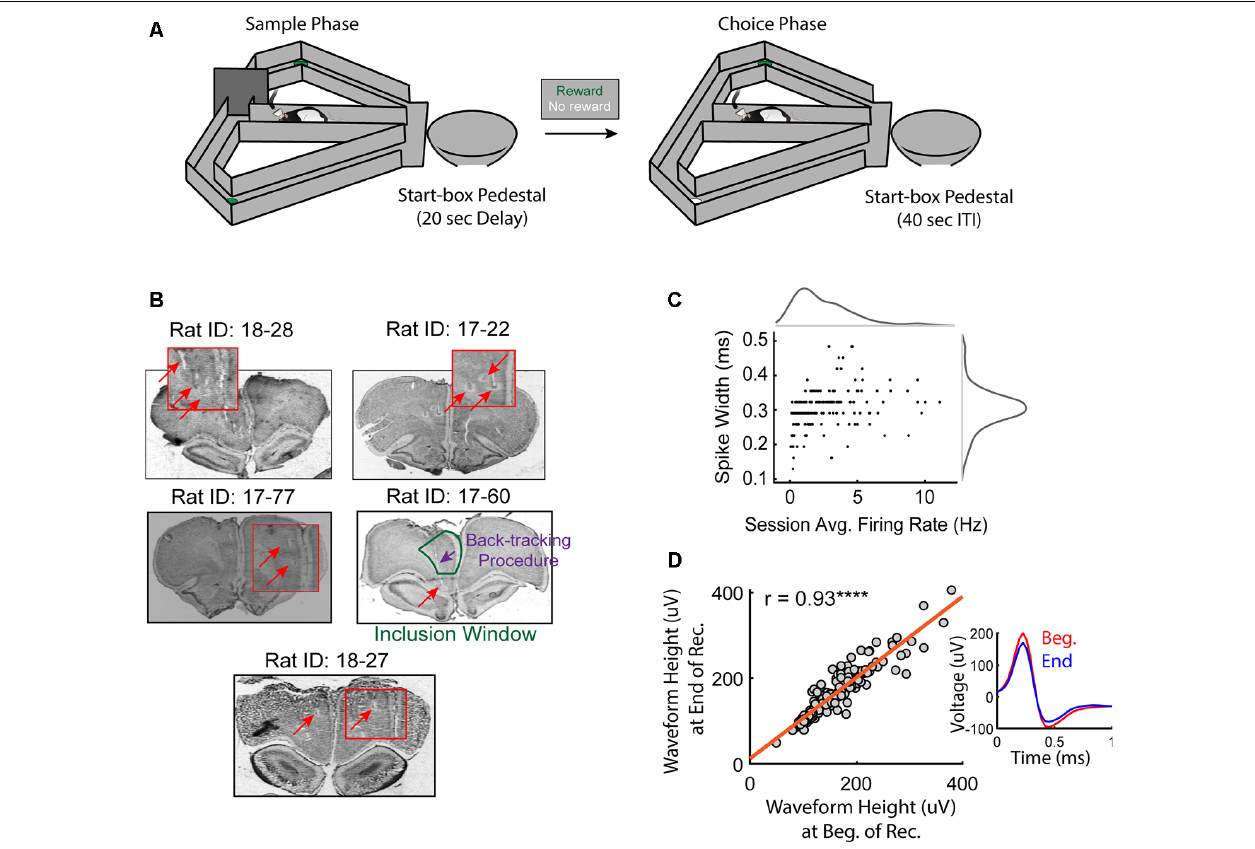
FIGURE 1 | Histological confirmations and recording stability. (A) Schematic of the delayed non-match to position (DNMP) task. Each trial of this task includes two traversals that are separated by a 20 s delay: a sample traversal in which one of the goal arms is blocked, forcing the rat to choose to enter the opposite goal arm and a choice traversal in which the rat is free to choose a goal arm but only rewarded for choosing the goal arm opposite to the arm visited on the sample traversal. Trials are separated by a 40 s inter-trial interval (ITI). For a more detailed description of the DNMP task, see “Materials and Methods” section. (B) Histological confirmations of final tetrode locations in the medial prefrontal cortex (mPFC). Note that in some cases, the final locations of tetrodes exceeded the window of inclusion (prelimbic and anterior cingulate cortex). Tetrode locations on specific recording days were estimated from the turn-count and final location of the tetrode (see “Materials and Methods” section). Red boxes are magnified images of the tetrode lesion (halo-marking) and/or the tetrode track (space). (C) Spike-widths were plotted against the session averaged firing rates for all included pyramidal neurons. Notice the Gaussian-like distribution for spike-widths in comparison to the session-averaged firing rates. (D) Only stable clusters were included for analysis. The average peak waveform height during the first 10 min of recording was strongly correlated to that of the last 10 min ( r = 0.93, **** p = 1.6e-81). The inset shows the average waveform of a representative neuron during the first (red) and last (blue) 10 min of the recording